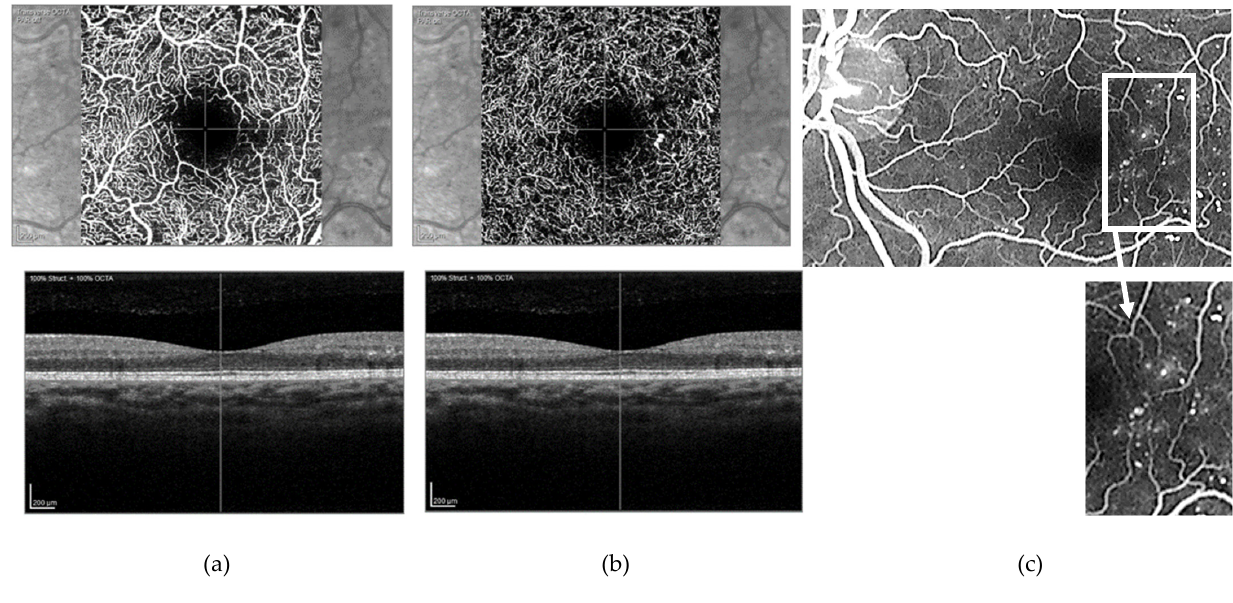
Figure 4. ( a ) Superficial and ( b ) deep retinal capillary plexuses as visualized using optical coherence tomography angiography (OCTA) and ( c ) corresponding fundus fluorescein angiogram (FFA). OCTA shows a well-preserved superficial capillary plexus ( a ) and what appears to be an area of capillary nonperfusion, supero-temporally to the foveal avascular zone (FAZ) and a microaneurysm temporally in the deep capillary plexus ( b ). FFA clearly shows multiple microaneurysms temporally to the FAZ (( c ) and inset) not seen in the superficial capillary plexus on OCTA; one of these is imaged in the deep capillary plexus on OCTA imaging. This suggests that FFA, in contrast to what has been previously stated in the literature, is able to determine changes in the deep capillary plexus and, under certain circumstances at least (such as the case shown here), allows better visualization of retinal capillary changes than OCTA.